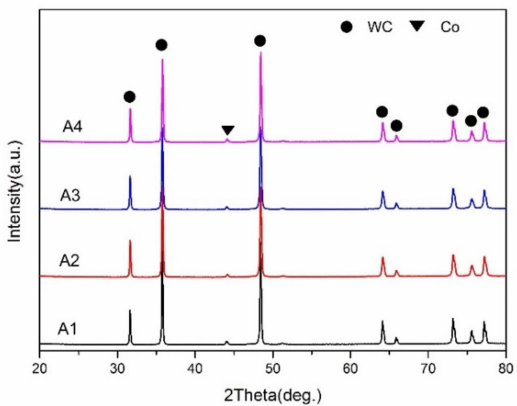
Figure 2. X–ray di ff raction (XRD) patterns of the sintered samples. A1: WC–10Co; A2: WC–10Co– 0.8Cr 3 C 2 ; A3: WC–10Co–0.8VC; A4: WC–10Co–0.8TaC.